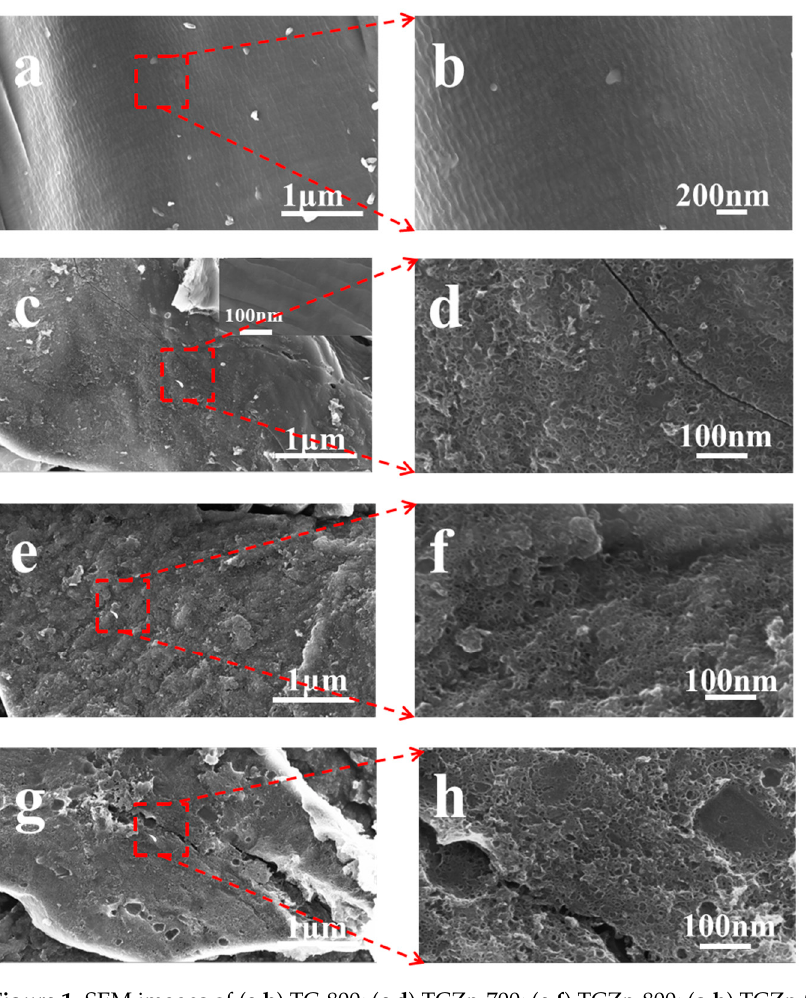
Figure 1. SEM images of ( a , b ) TC-800; ( c , d ) TCZn-700; ( e , f ) TCZn-800; ( g , h ) TCZn-900.